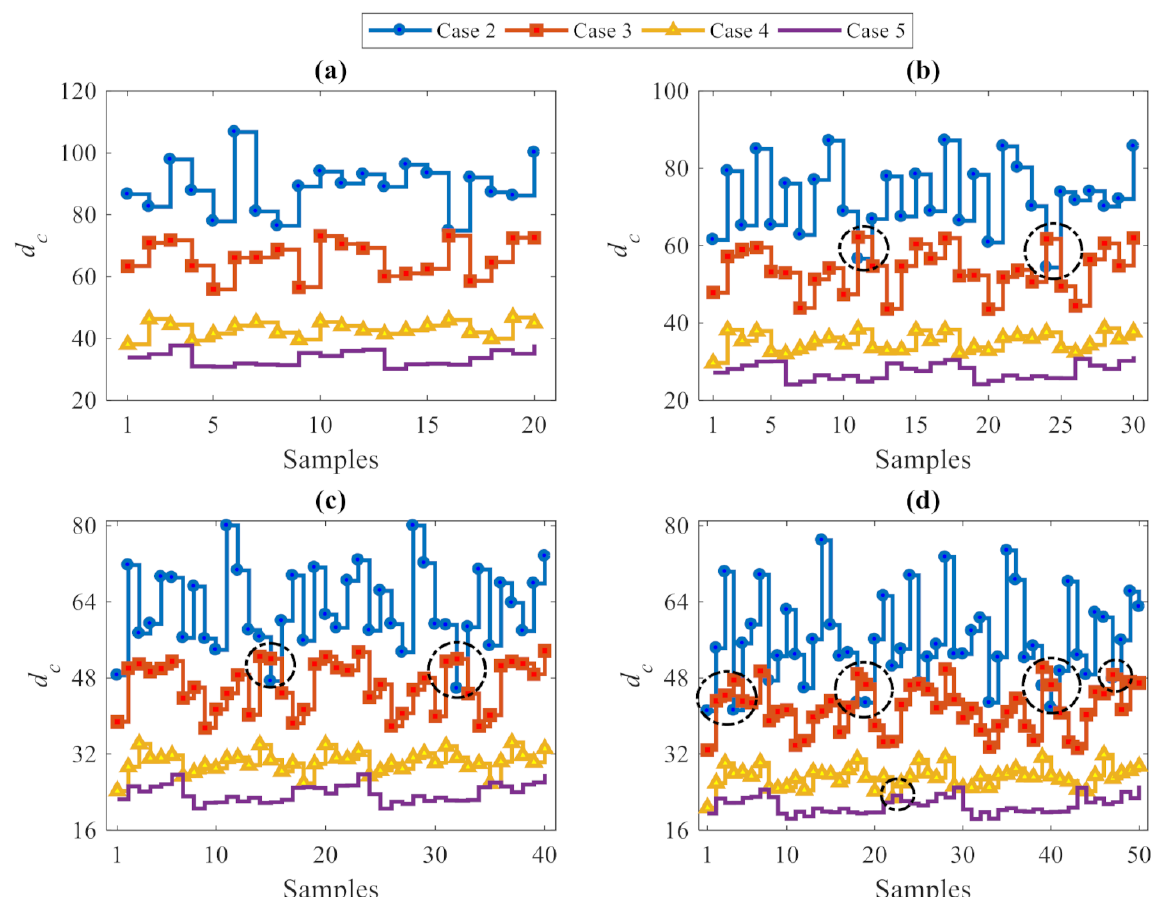
Figure 8. ASCE problem: estimation of damage severity for Cases 2–5, see Table 2, at varying number of partitions ( a ) p = 20, ( b ) p = 30, ( c ) p = 40, and ( d ) p =